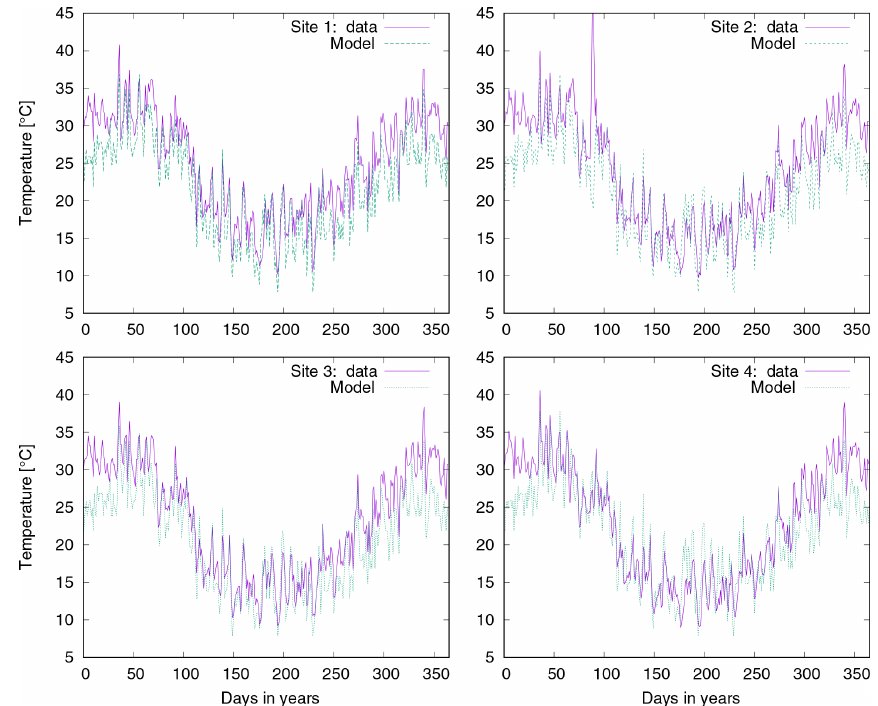
Figure A5. Comparison of measured and simulated surface temperature for one biocrust type (dark cyanobacteria-dominated biocrust) and four field sites at